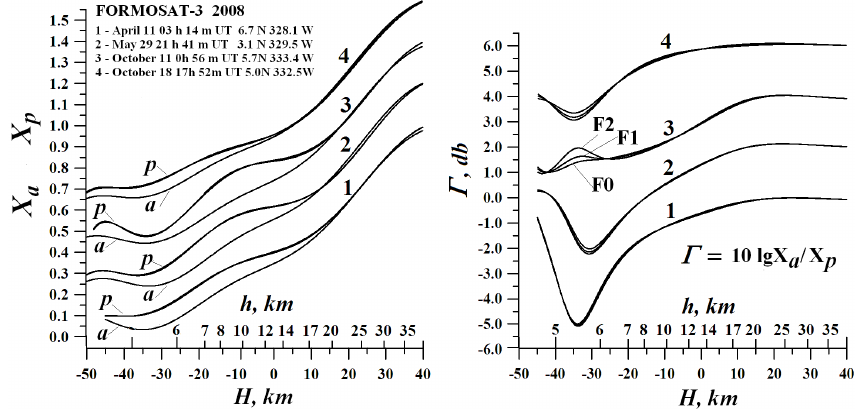
Figure 4. Left plot – Comparison of the polynomial approximations of refractive attenuations X a (h) , X p (h) (curves 1–4, indexes “p” and “a”, respectively). Curves 2–4 are displaced for convenience by 0.6; 0.4; 0.2, respectively. Right – The total absorption (cid:48) corresponding to the refractive attenuations X a (h) , X p (h) has been calculated from the curves 1–4 (left panel). Curves 2, 3, and 4 are shifted for convenience by 2, 4, and 6db,